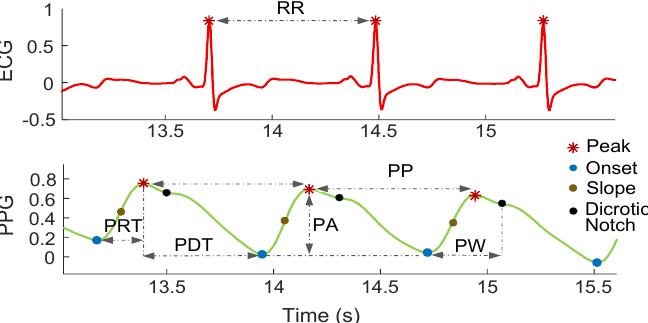
Figure 7. Biomarkers and fiducial points extracted from ECG and PPG signals. PRT: pulse rising time, PDT: pulse decreasing time, PA: pulse amplitude, PP: pulse period, PW: pulse width, RR interval: beat-to-beat time interval detected from the